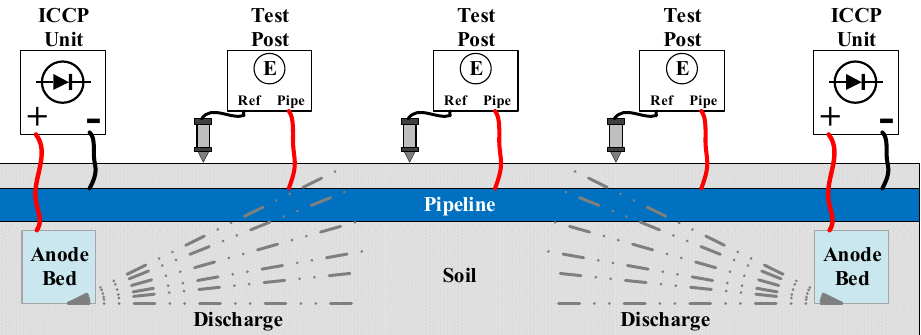
Figure 1. Typical pipeline CP system. Source: adapted from